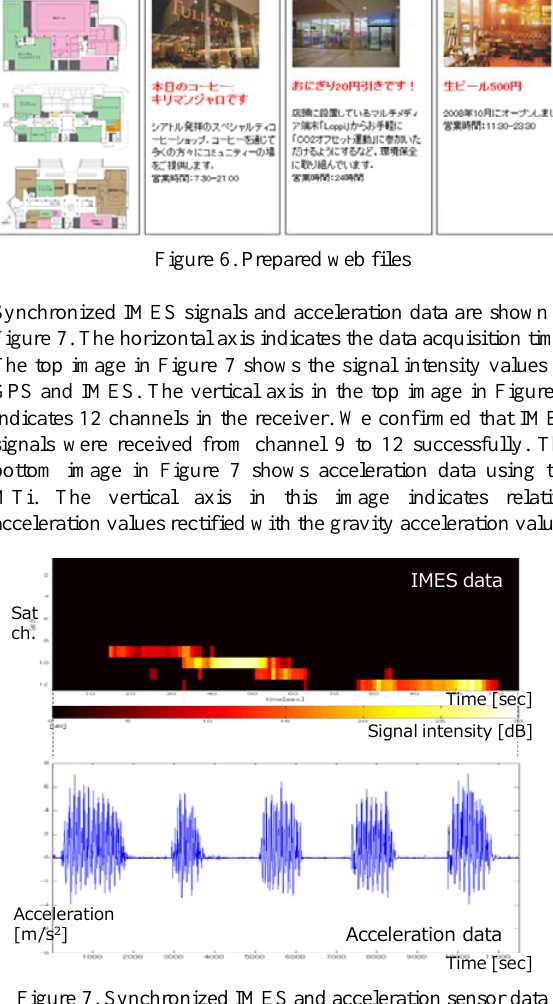
Figure 7. Synchronized IMES and acceleration sensor